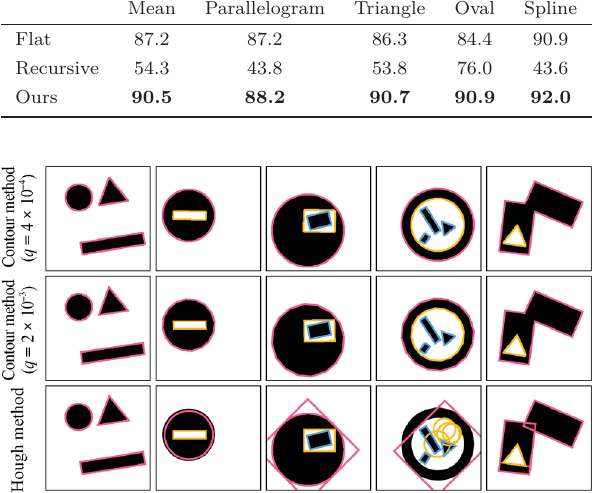
Table 3 Average precision (AP) measures of learning-based shape detection methods. Values are presented in percentage Mean